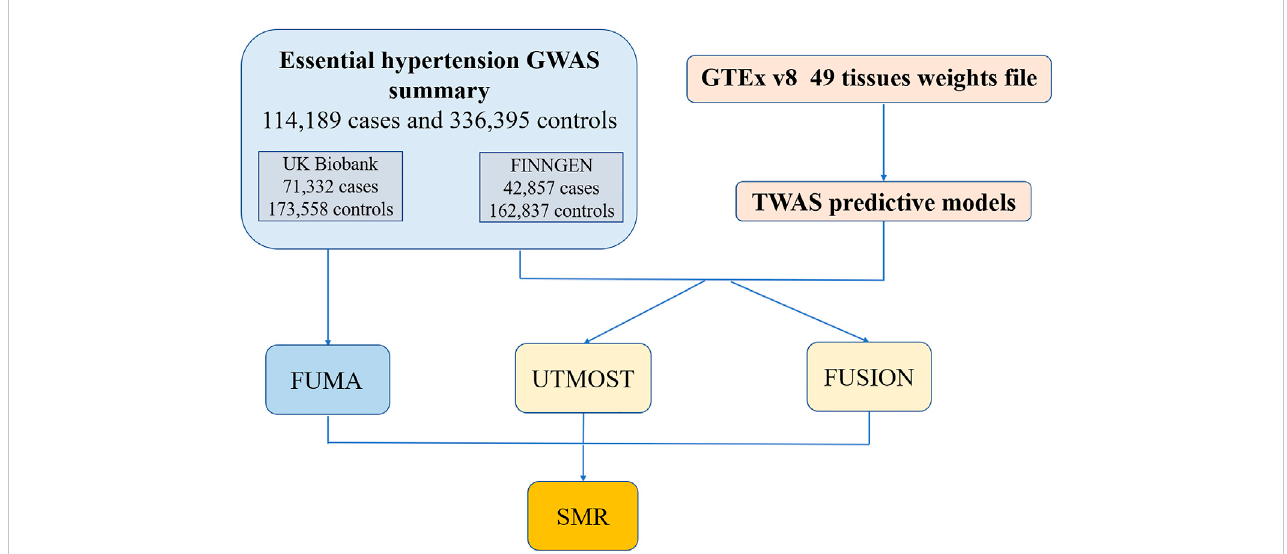
FIGURE 1 The work fl ow of the study. GWAS, genome-wide association; GTEx, Genotype-Tissues Expression Project; TWAS, transcriptome-wide association studies; FUMA, functional mapping and annotation; UTMOST, uni fi ed test for molecular signatures; FUSION, functional summary-based imputation; SMR, summary-data-based Mendelian randomization.